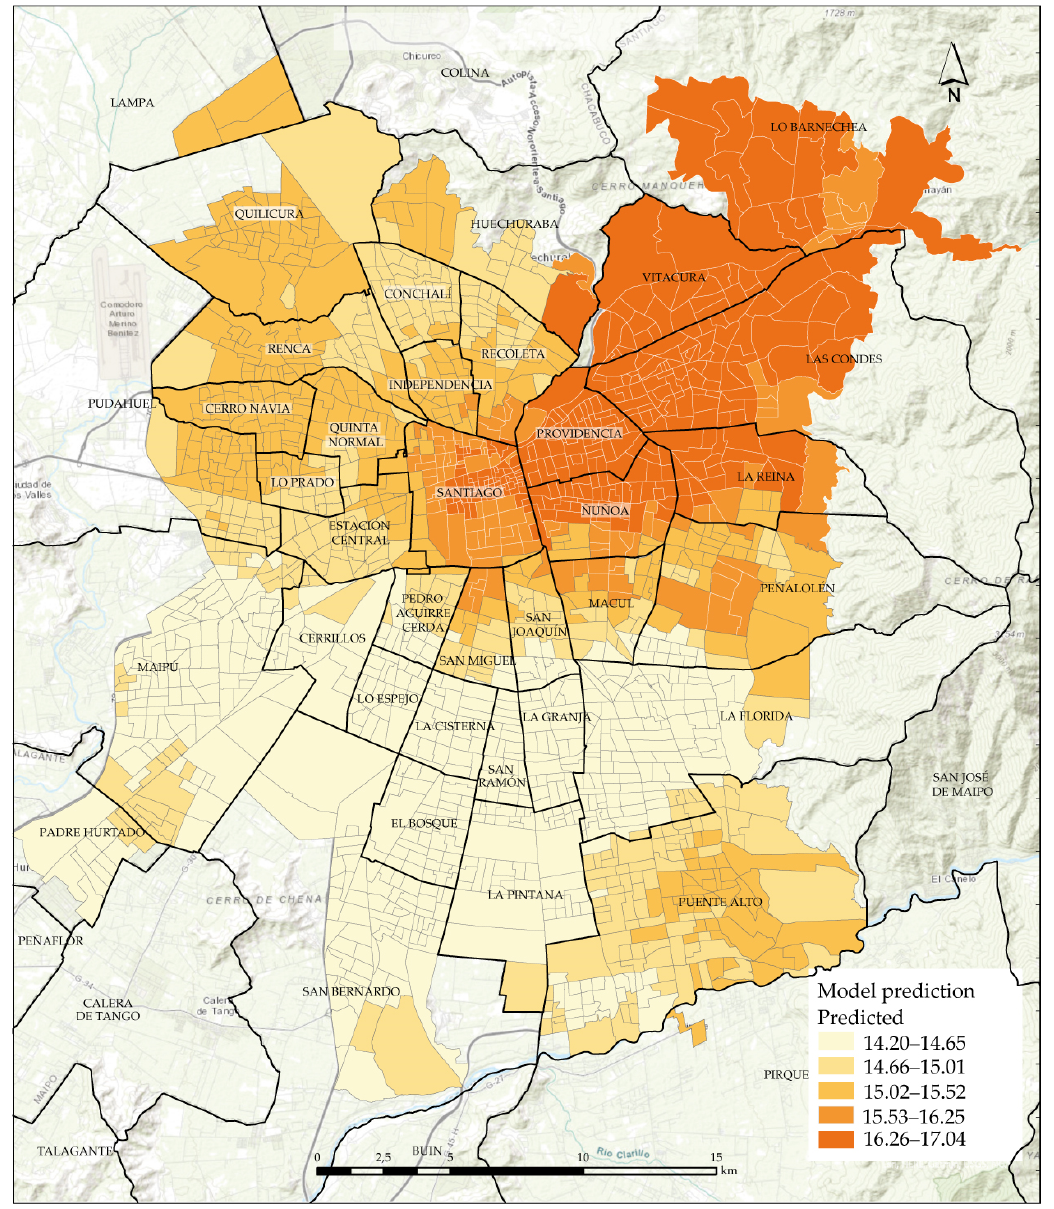
Figure 6. GWR model prediction by census tract unit.